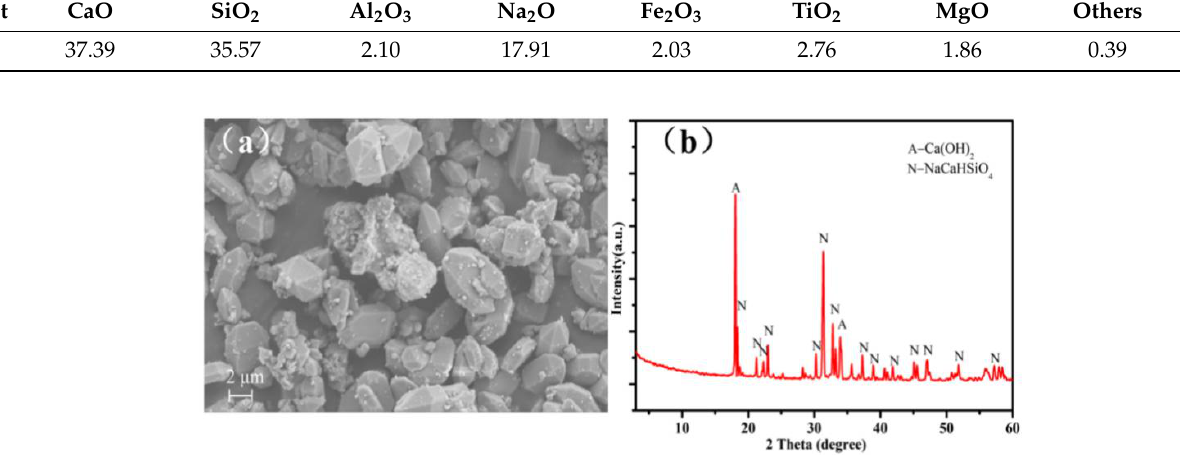
Figure 1. Scanning electron microscope (SEM )image ( a ) and X-ray diffractometer (XRD) pattern ( b ) of alumina-extracted residue (AER).